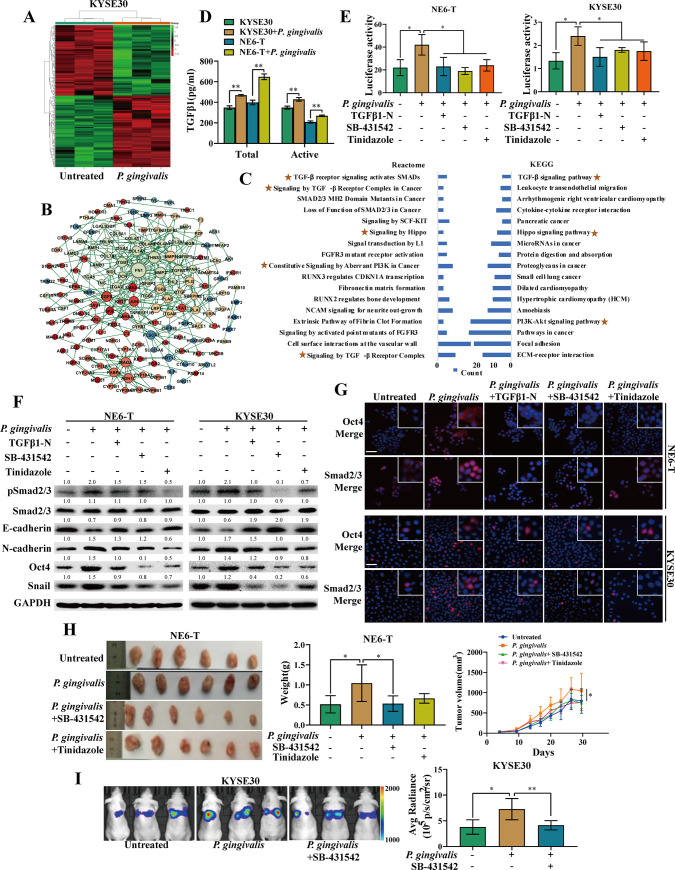
P. gingivalis activates TGFβ/Smad signaling in ESCC cells.(A) The heatmap illustrates the differentially expressed genes in response to P. gingivalis in KYSE30 cells from 3 independent experiments. Red and green indicate up-regulated and down-regulated genes, respectively. (B) Two-hundred forty-five genes with differential expression were used to build a subnetwork that consisted of 74 linker genes and 86 seed genes. Bigger size and red color direction indicate higher degree and higher betweenness, respectively. (C) Pathway enrichment analyses (left, Reactome; right, KEGG) were conducted to identify pathways affected by P. gingivalis. Star denotes overlapped biological pathways. (D) ELISA was performed to measure the total and active TGFβ secreted from NE6-T and KYSE30 cells cultured with or without P. gingivalis. (E) Dual luciferase assay of Smad reporter was measured in NE6-T and KYSE30 cells with different treatments. Renilla luciferase activity was normalized to firefly activity as relative luciferase activity. *P< 0.05, **P < 0.05, by Student t test. (F) Western blot was performed to detect the indicated proteins in NE6-T and KYSE30 cells with different treatments. GAPDH served as the loading control. (G) Immunofluorescence microscopy of Smad2/3 and Oct4 was observed in NE6-T and KYSE30 cells with different treatments. Scale bar, 50 μm. (H) Representative data of xenograft tumors from NE6-T cells receiving different treatments, the tumor weight (*P < 0.05 by one-way ANOVA), and the tumor growth curve (*P < 0.05 by one-way ANOVA and Bonferroni multiple comparison test). (I) Representative bioluminescence images and quantification of photon flux (***P < 0.05; **P < 0.01, Mann–Whitney U test) in different groups of mice. Results represent means ± SD. Akt, v-akt murine thymoma viral oncogene homolog; ANOVA, analysis of variance; CDKN1A, cyclin-dependent kinase inhibitor 1; ECM, extracellular matrix proteins; ESCC, esophageal squamous cell carcinoma; FGFR3, fibroblast growth factor; GAPDH, glyceraldehyde-3-phosphate dehydrogenase; HCM, hypertrophic cardiomyopathy; KEGG, Kyoto Encyclopedia of Genes and Genomes; MH2, mad-homology domain 2; NCAM, neural cell adhesion molecule; PI3K, phosphatidylinositol 3 kinase; pSmad, phosphorylated Smad; RUNX, runt-related transcription factor; Smad, Drosophila mothers against decapentaplegic homolog; TGFβ, transforming growth factor-β; TGFβ1-N, TGFβ1 neutralizing antibody.